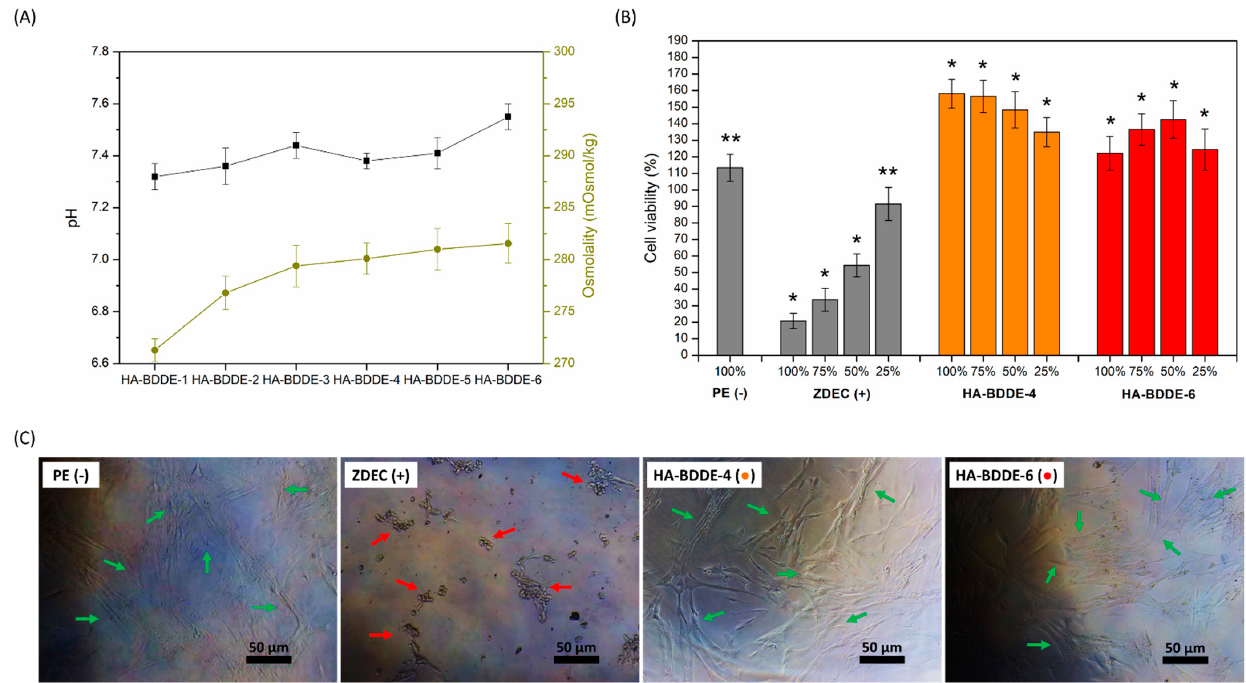
Figure 4. ( A ) Osmolality and pH values of HA-BDDE gels, ( B ) CCL-171 cell viabilities, and ( C ) photographs of damaged ( ↑ , rounded) and healthy ( ↑ , elongated) cells at 100% concen- tration of PE ( − ), ZDEC (+), HA-BDDE-4 ( • ), and HA-BDDE-6 ( • ). * Significant differences ( p < 0.05), ** non-significant differences ( p >